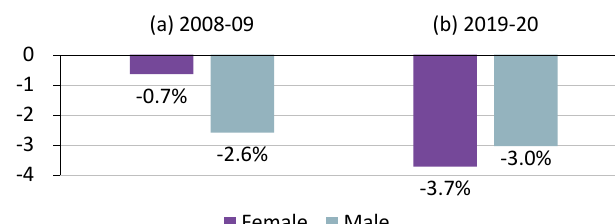
Figure 1. Percent change in OECD total employment by gender during the global financial crisis (2008 − 2009) and the COVID-19 pandemic (2019 − 2020). Notes: Workers aged 15–64; data from